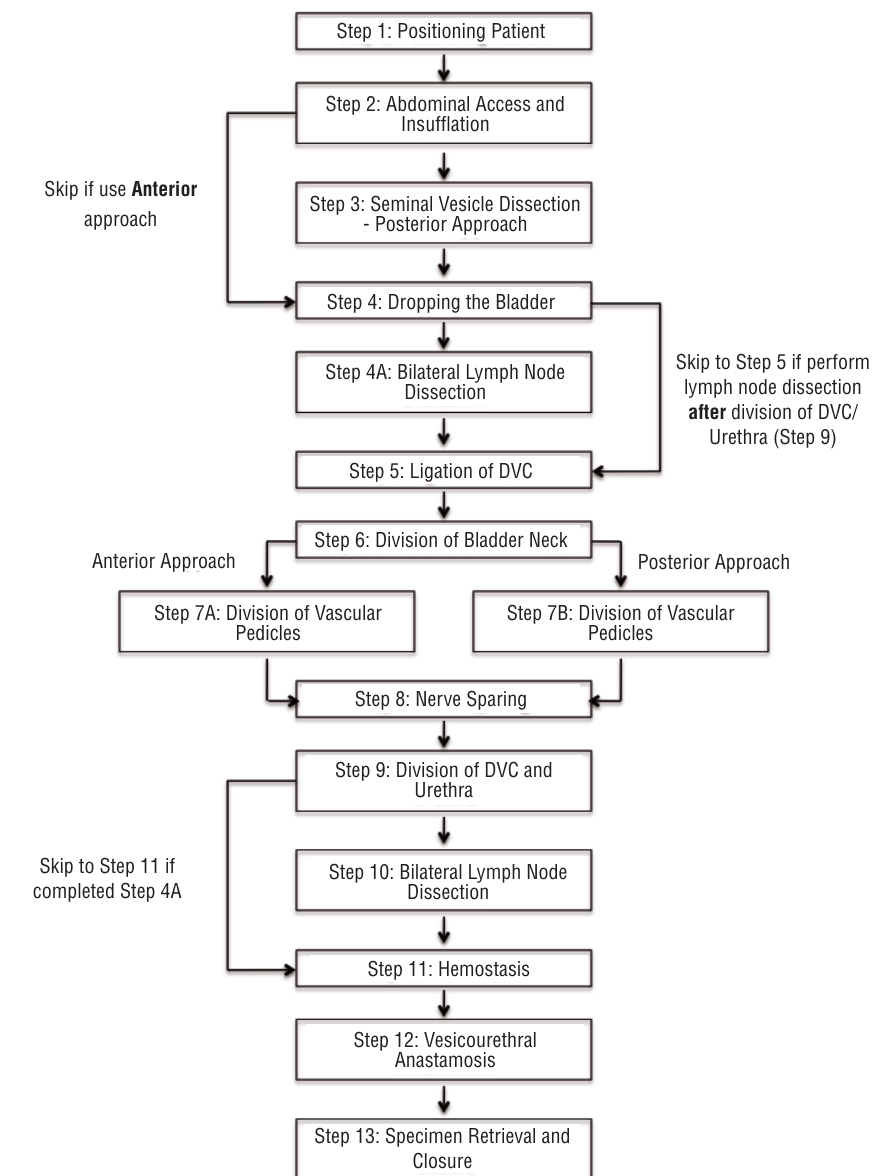
figure 1 - critical steps for RARp